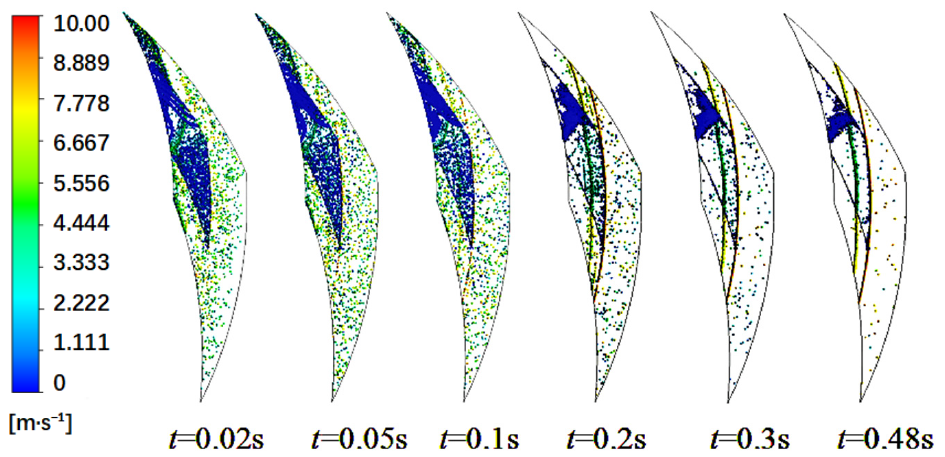
Figure 7. Distribution and movement of particles with time.